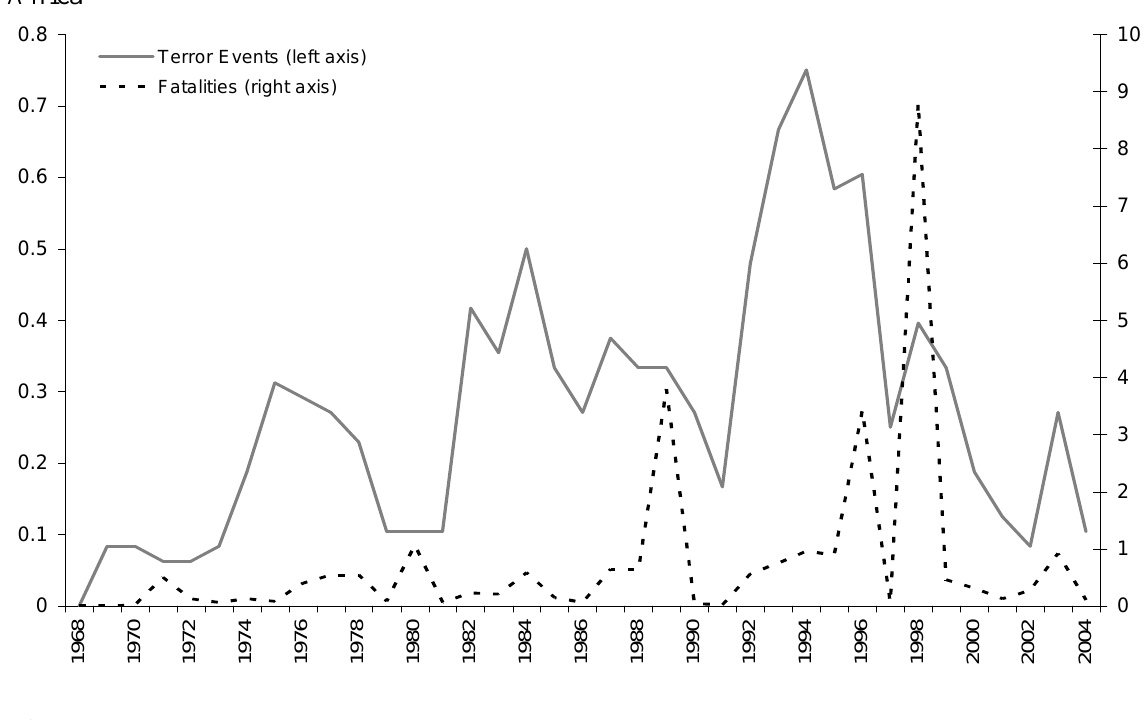
Average Number (per Country) of International Terrorist Events and Fatalities in Sub-Saharan